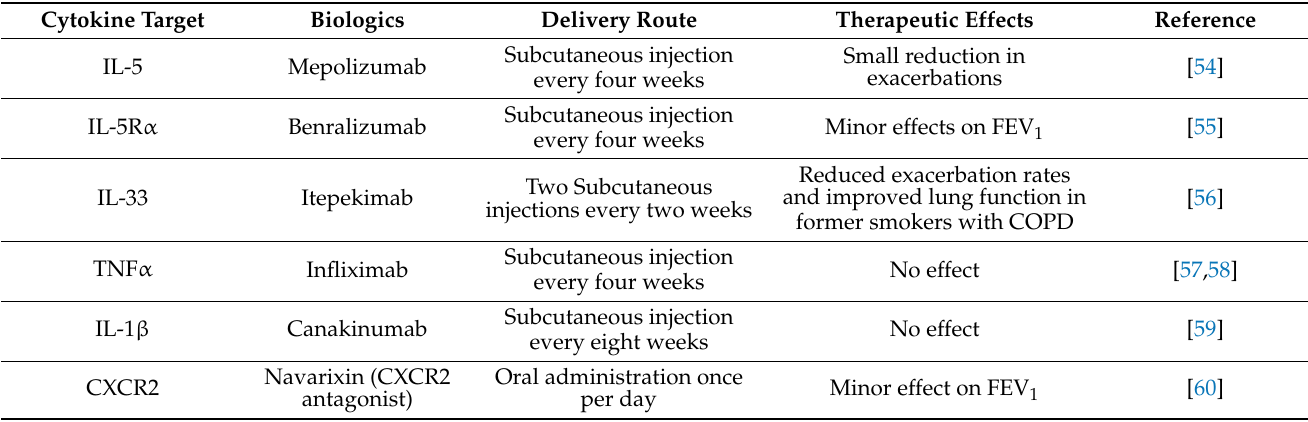
Table 1. Biologics used to treat